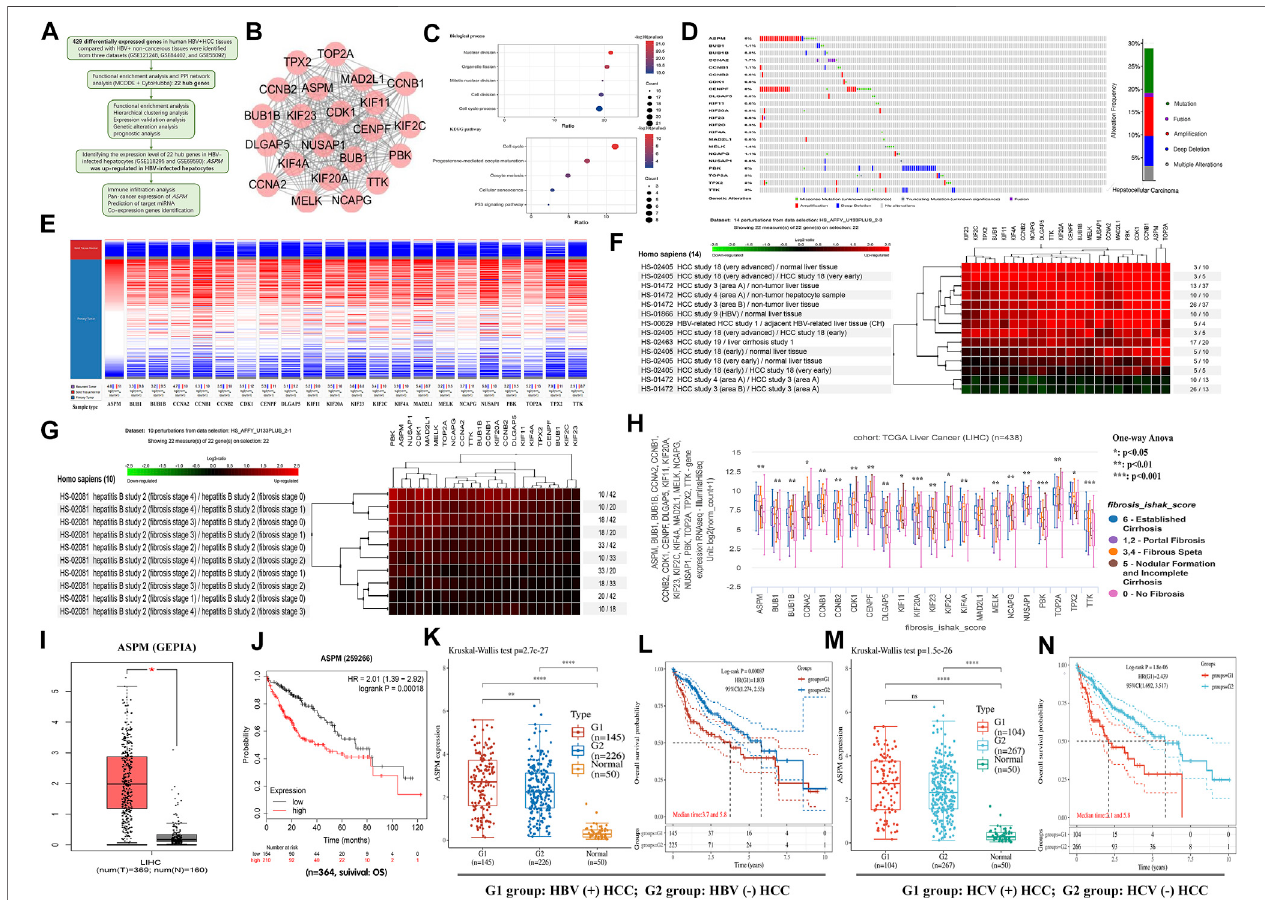
FIGURE1|(A) Work fl owofthepresentstudy. (B) ThePPInetworkof22hubgeneswasperformedbytheSTRINGtool. (C) BiologicalprocessandKEGGpathway analysis of ASPM . (D) The genetic alteration analysis of 22 hub genes was performed by the cBioportal database (E) Hierarchical clustering of ASPM was constructed based on the UCSC database. (F) A Heatmap of ASPM expression in HCC tissues was constructed using GENEVESTIGATOR software. (G) A Heatmap of ASPM expression in liver fi brosis tissues was constructed using GENEVESTIGATOR software. (H) Box plot of ASPM mRNA expression in different stages of liver fi brosis tissues was created by UCSC online tool evaluated by the one-way Anova test (I) ASPM expression in liver tumor and normal people were veri fi ed using GEPIA online tool. (J) Overall survivalanalysisofHCC patients withdifferent ASPM expression levelswasperformedusing theKaplan Meierplotterdatabase. (K) ASPM expression in HBV (+) HCC, HBV (-) HCC, and adjacent non-tumor tissues were explored using the TCGA database. (L) Overall survival analysis of HBV (+) HCC patients compared with HBV (-) HCC patients was performed using the TCGA database. (M) ASPM expression in HCV (+) HCC, HCV (-) HCC, and adjacent non-tumor tissues